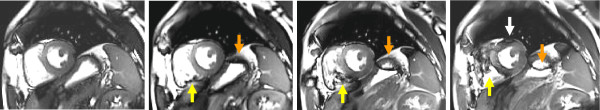
Short-axis, SSFP images acquired at four different repetition times (TR's), ranging from 2.3msec (far left) to 5.0msec (far right). As TR is increased, artifacts due to susceptibility and field inhomogeneity are seen in the RV (yellow arrow), at the diaphragm (orange arrow), is and of the anterior and lateral walls of myocardium (white arrows).